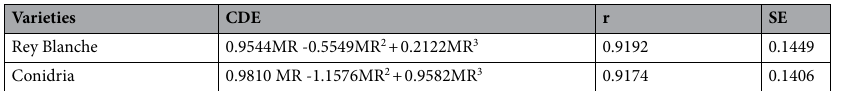
Table 5. Polynomial equations of the characteristic drying equations for both tested fig varieties.